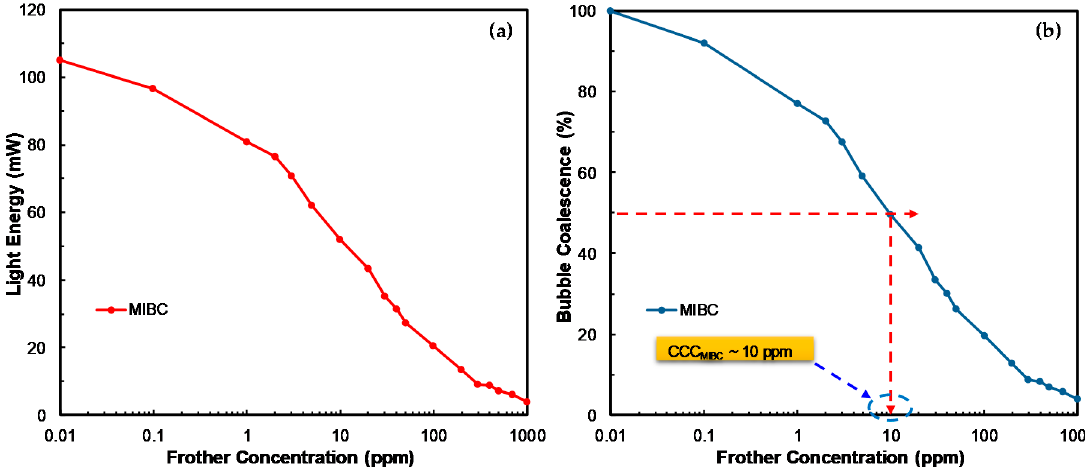
Figure 2. ( a ) Light energy, ( b ) % bubble coalescence values as a function of MIBC concentration.